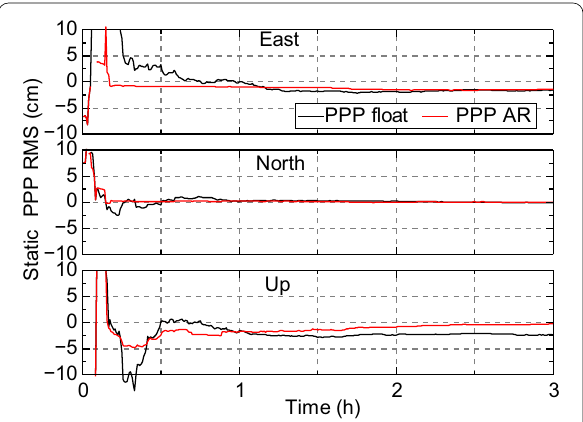
Fig. 10 Static PPP positioning errors for station YARR with 3-h data